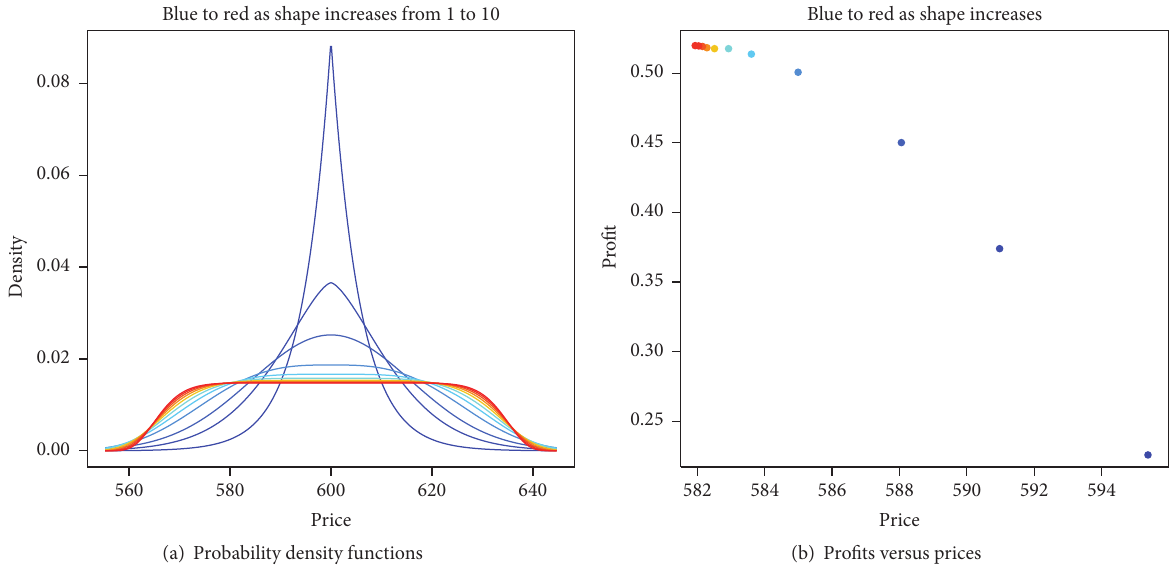
Figure 2: Probability density functions of prices and output from the analysis in Section 4.1 for GED (𝜇,𝑠, ] ) distribution with varying shape (from blue ( ] = 0.5 ) to red ( ] = 10 , quasiuniform)) and the rest of parameters as in the benchmark case ( 𝜇 = 600, 𝜎 2 = 125, 𝑁 = 10 ); see